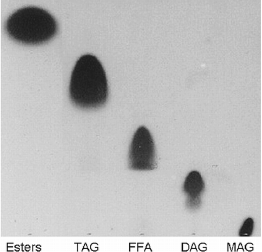
Fig. 4. The effect of reaction time on Lipoprime 50T-catalyzed rapeseed oil methanolysis with 1:4 rapeseed oil to methanol molar ratio at 30 °C in t -butanol. Control – RO. Symbols are the same as in Fig. 2